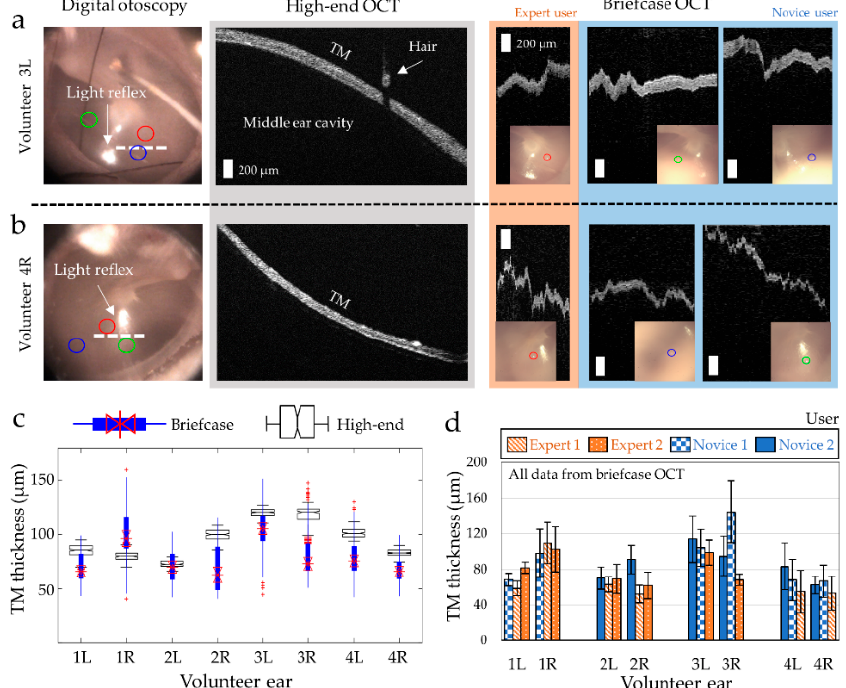
Figure 4. Side-by-side comparisons of middle ear images acquired from the high-end OCT system and the briefcase system. ( a , b ) Representative high-resolution digital otoscopy (white dotted line—the scanning region of the high-end OCT; circles—the focus of the briefcase OCT from the three different users), high-end OCT images and briefcase OCT images of the healthy middle ear; ( c ) overlaid box plots of the TM thickness measured from the briefcase (blue) and the high-end OCT system (black); ( d ) bar graphs comparing the user variability in TM thickness measured from the briefcase system. Each statistical comparison is shown in Supplementary Information Table